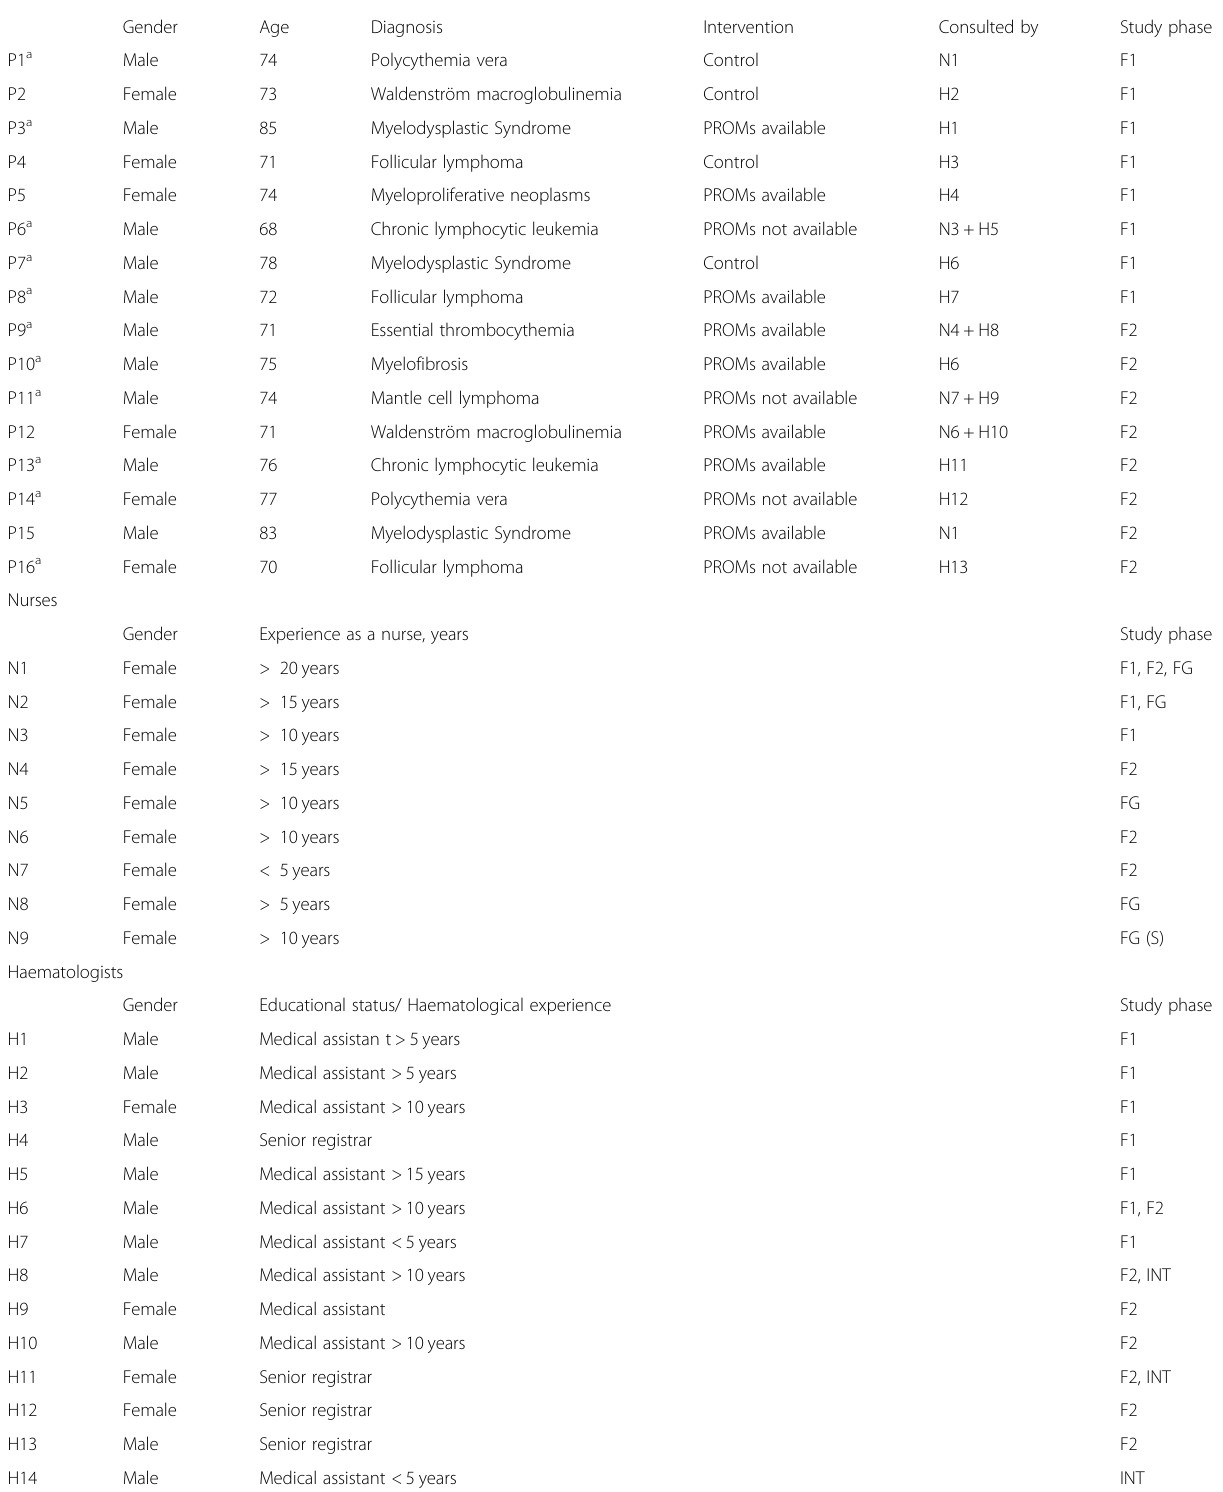
Table 1 Patients, nurses and haematologists participants included in the qualitative study